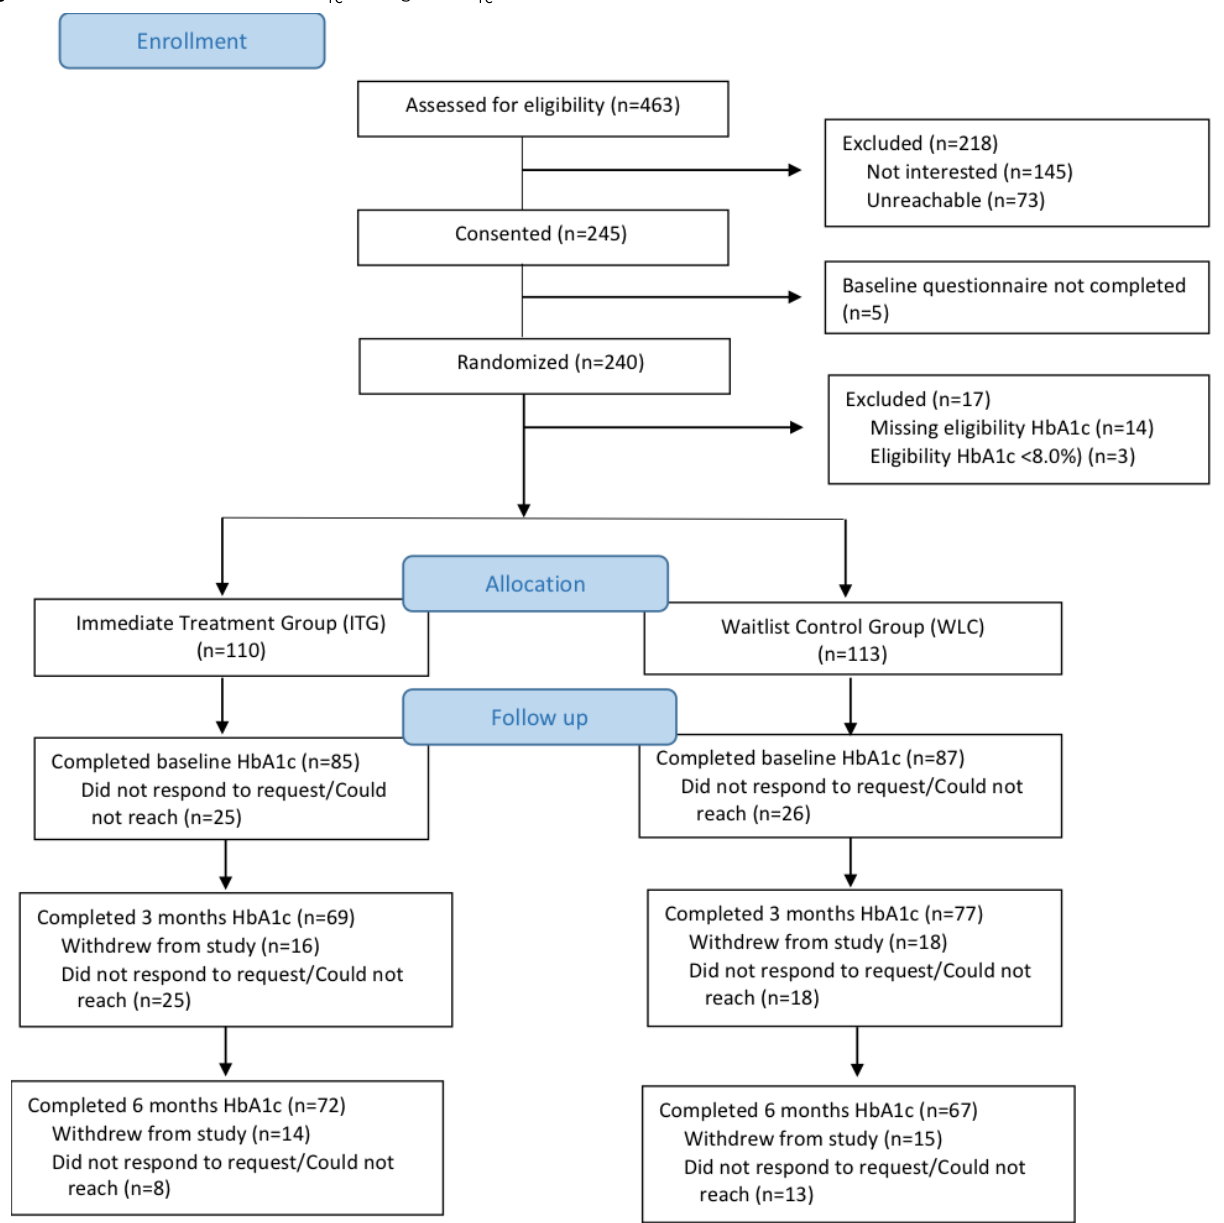
Figure 1. Flowchart of enrollment. HbA 1c : hemoglobin A 1c